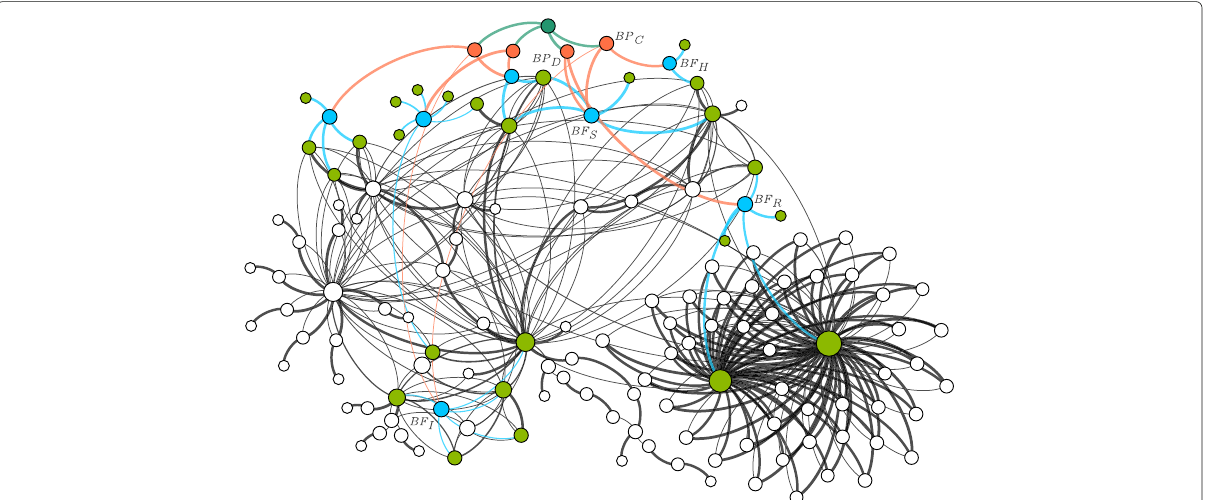
Fig. 4 Mission dependency model and resource dependency model obtained and learned from data of the use case partner. BF R represents a business function ( blue ) subject to handling remote terminal units (RTUs), which are visible as the lower right clouds of nodes, where the central nodes are business critical devices ( green ). Business processes shown in orange , business company in darkgreen . Thicker and darker edges represent higher dependency degrees. Visualized using Gephi [50]